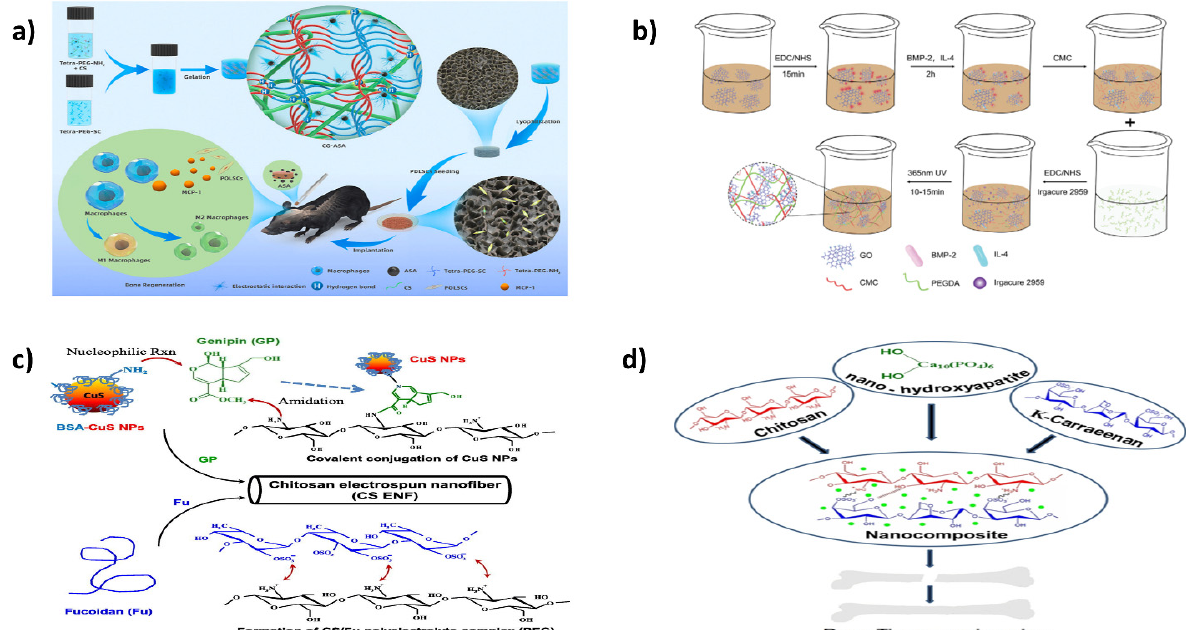
Figure 4. ( a ) Production of a biocompatible composite gel with long-lasting aspirin release for bone tissue regeneration [179]; ( b ) An interpenetrating network hydrogel with a GO-based controlled release mechanism induced M2-type macrophage differentiation for defective bone healing. Reproduced with permission from [183], copyright Wiley Online Library 2021; ( c ) CuS and fucoidan-modified chitosan nanofibers for antimicrobial and bone tissue regeneration. Reproduced with permission from [184], copyright Elsevier 2022; ( d ) Nanocomposite biomaterials for bone regeneration produced from nano-hydroxyapatite impregnated in Chitosan/ κ -Carrageenan. Reproduced with permission from [185], copyright Wiley Online Library 2022.